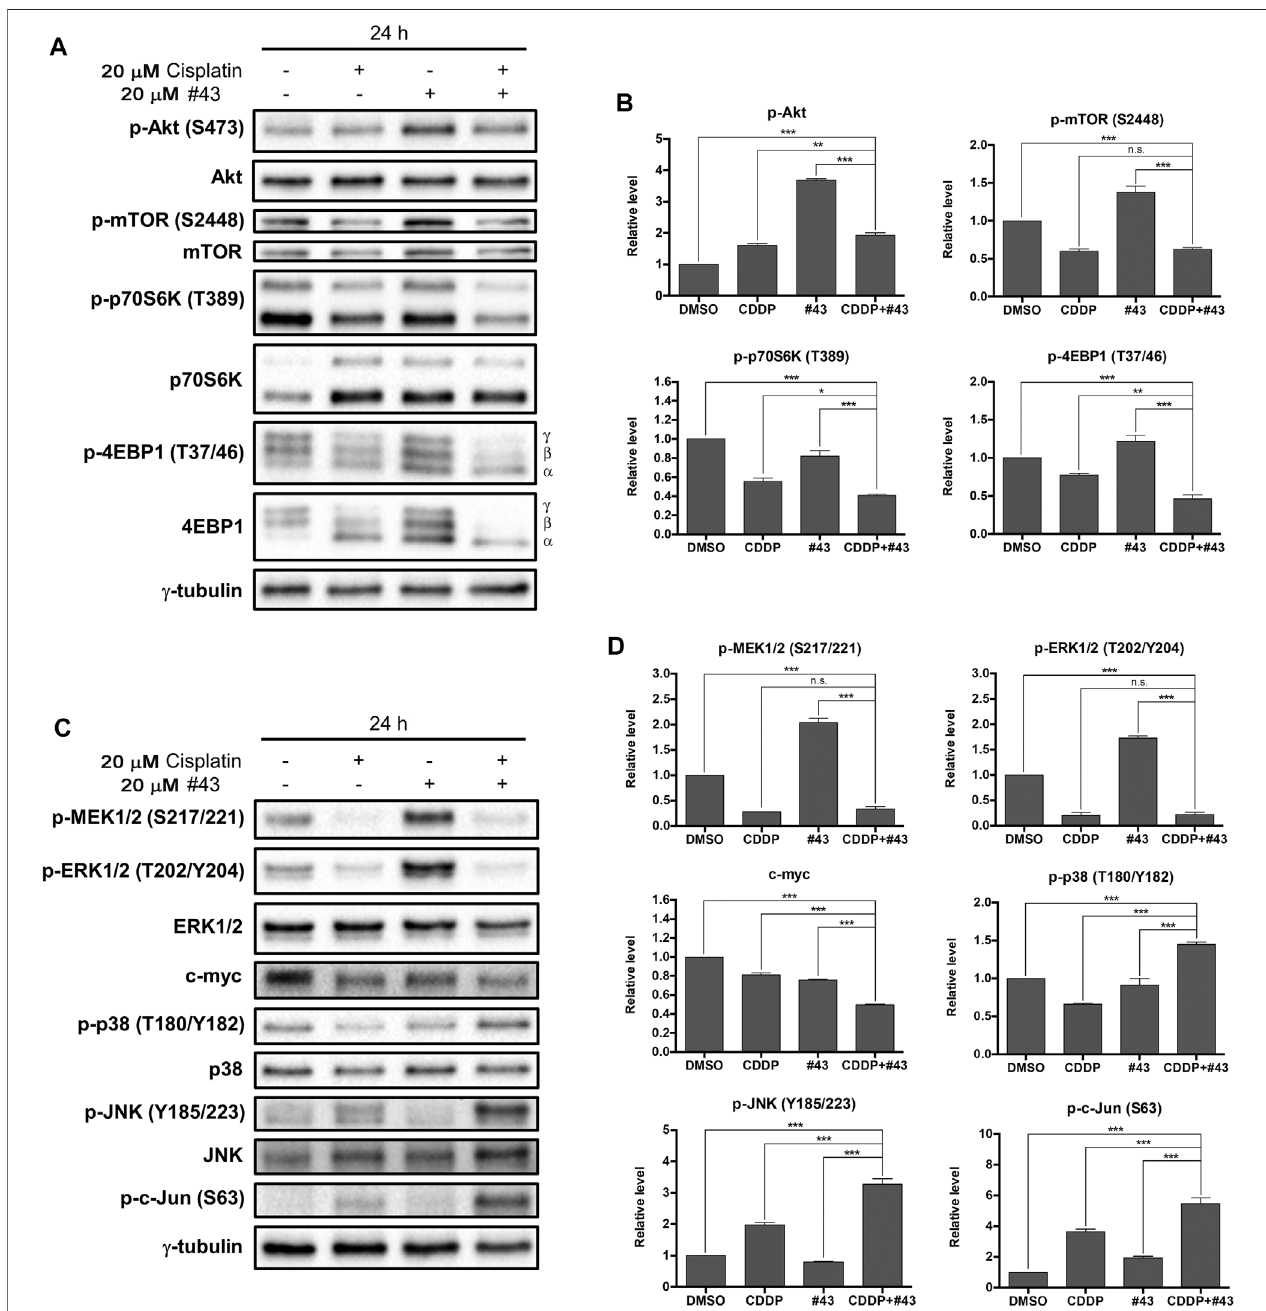
FIGURE 6 | Effects of cisplatin and #43 on proteins involved in the Akt/mTOR and MAPK signaling pathways in MCF-7 cells. (A) Western blot analysis of the Akt/ mTOR signaling pathway-related proteins. The α , β , γ isoforms represent the phosphorylation status of 4EBP1. γ -4EBP1 is the hyperphosphorylated isofrom and α - 4EBP1ishypophosphorylatedisoform. (B) QuantitativeresultsofWesternblotanalysisofproteinsrelatedtotheAkt/mTORsignalingpathway. (C) Westernblotanalysis of the MAPK signaling pathway-related proteins. (D) Quantitative results of Western blot analysis of proteins related to the MAPK signaling pathway. Cells were treated with 20 μ M cisplatin and/or 20 μ M #43 for 24 h, and harvested for Westernblot analysis. The relative protein levels were quanti fi ed by Image Lab software using γ -tubulin astheloadingcontrol. Dataarepresentedasmean±SEMofat leastthree independent experiments. *, p < 0.05;** p < 0.01;***, p < 0.001;n.s., notsigni fi cant ( p > 0.05) by one-way ANOVA followed by Bonferroni t -test.